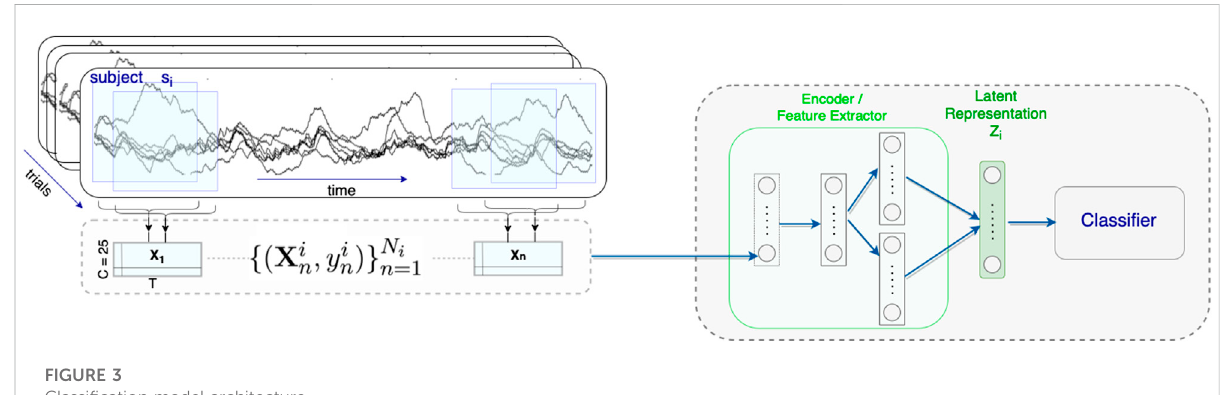
FIGURE 3 Classi fi cation model